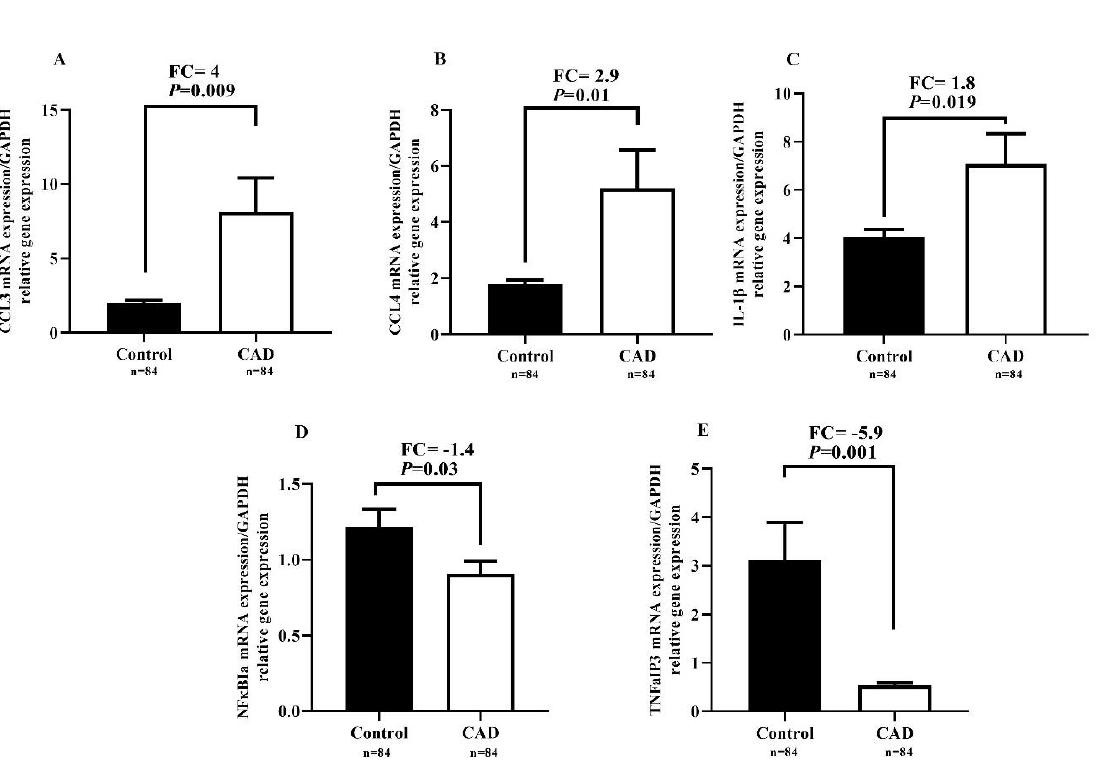
Figure 1: Relative expression levels of CCL3 , CCL4 , IL-1β , TNFαIP3 , and NF-κBIα genes in CAD and control groups. P -values ≤0.05 were considered as significant using independent-samples t-test.